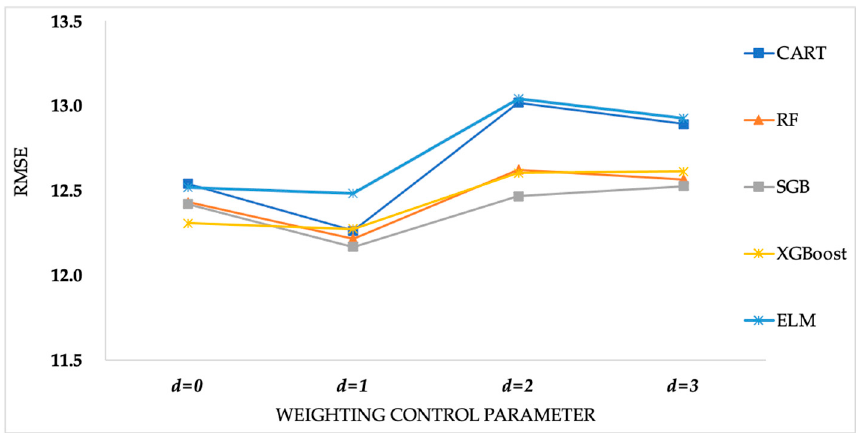
Figure 6. Prediction performance of prediction models with weighting control parameter ( d ) from 0 to 3 under game-lag ( l ) = 3.